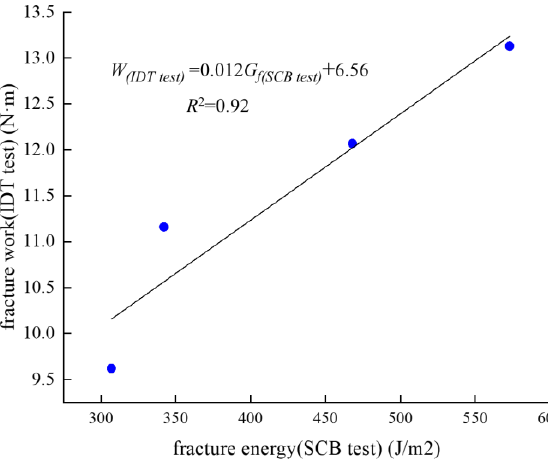
Figure 11. The correlation between fracture energy and fracture work.